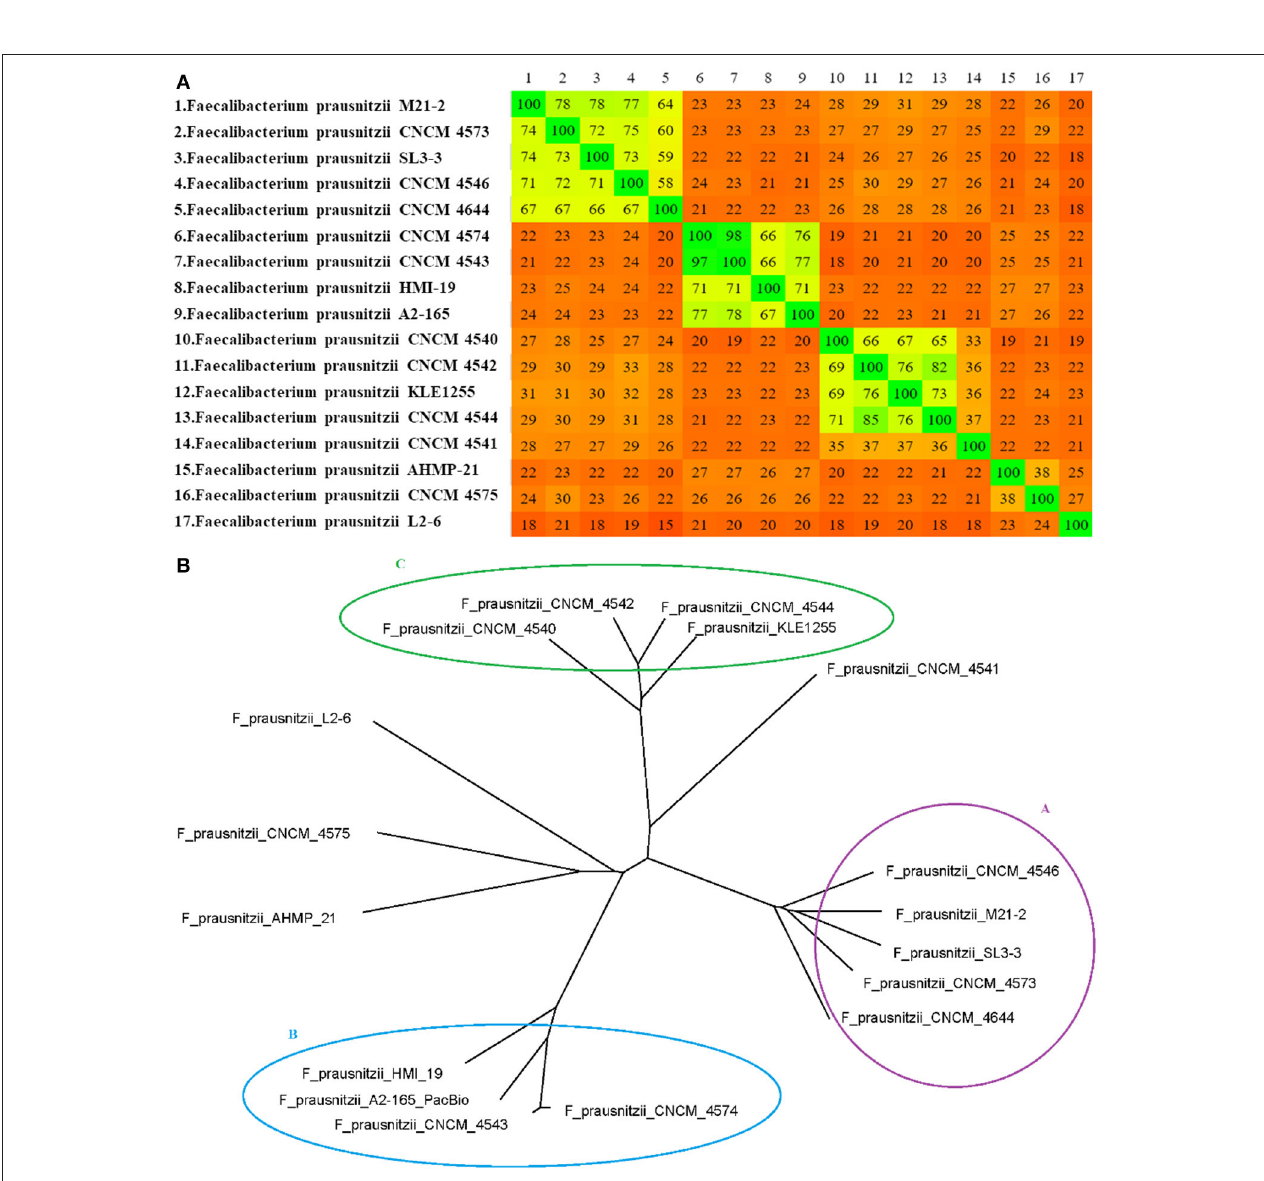
FIGURE 2 | (A) Heatmap and (B) distance-matrix-based phylogenetic network of F. prausnitzii . The numbers in the heatmap show the percentage of similarity between genomes; the colors vary from red (low similarity) to green (high similarity). The network was constructed using SplitsTree software with NeighborNet and equal angle methods, based on a distance matrix from Gegenees